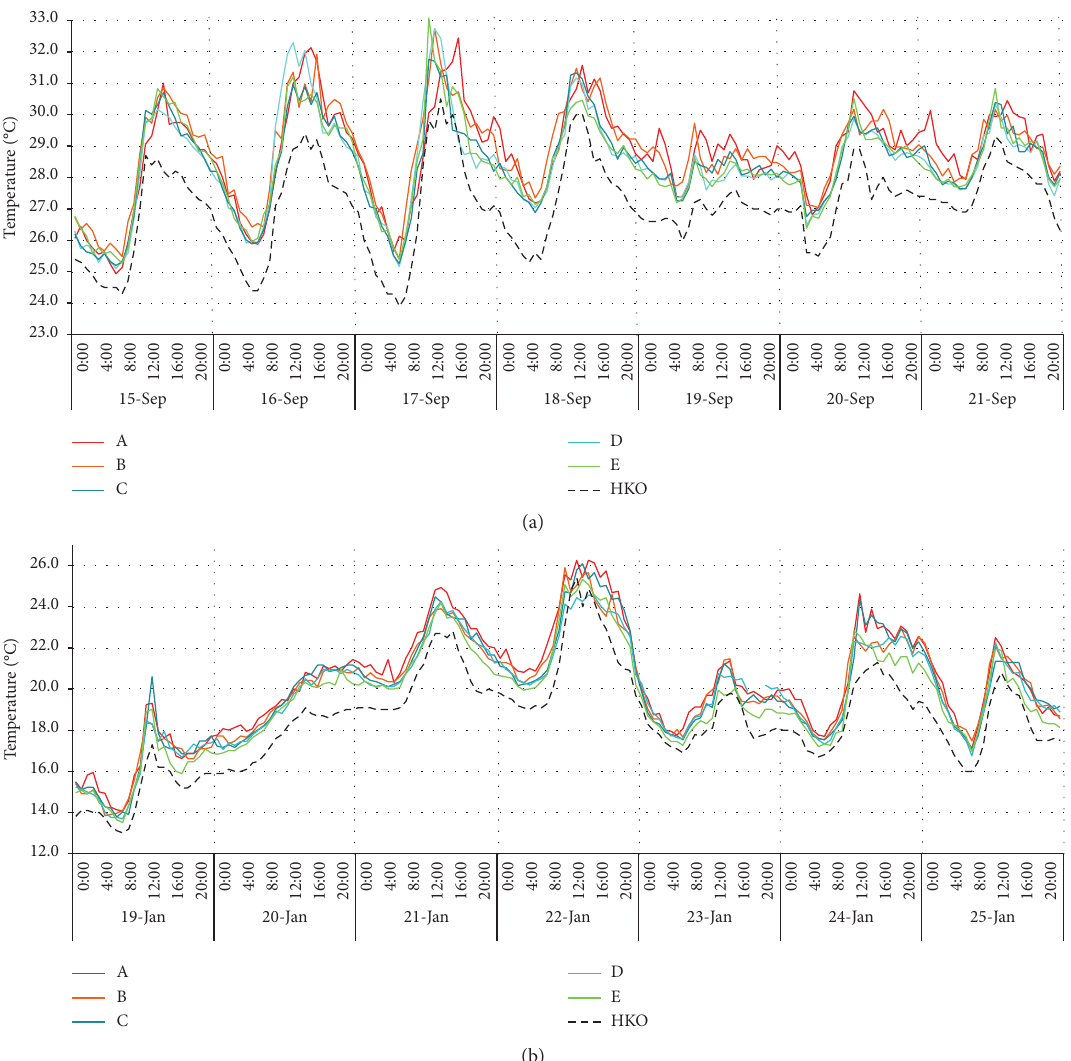
Figure 3: Hourly temperature changes at points A to E over 7 days for both (a) summer and (b) winter. Note that, for comparison, the official urban temperatures measured by the Hong Kong Observatory (black dashed lines) were plotted alongside and registered lower readings consistently throughout the period.